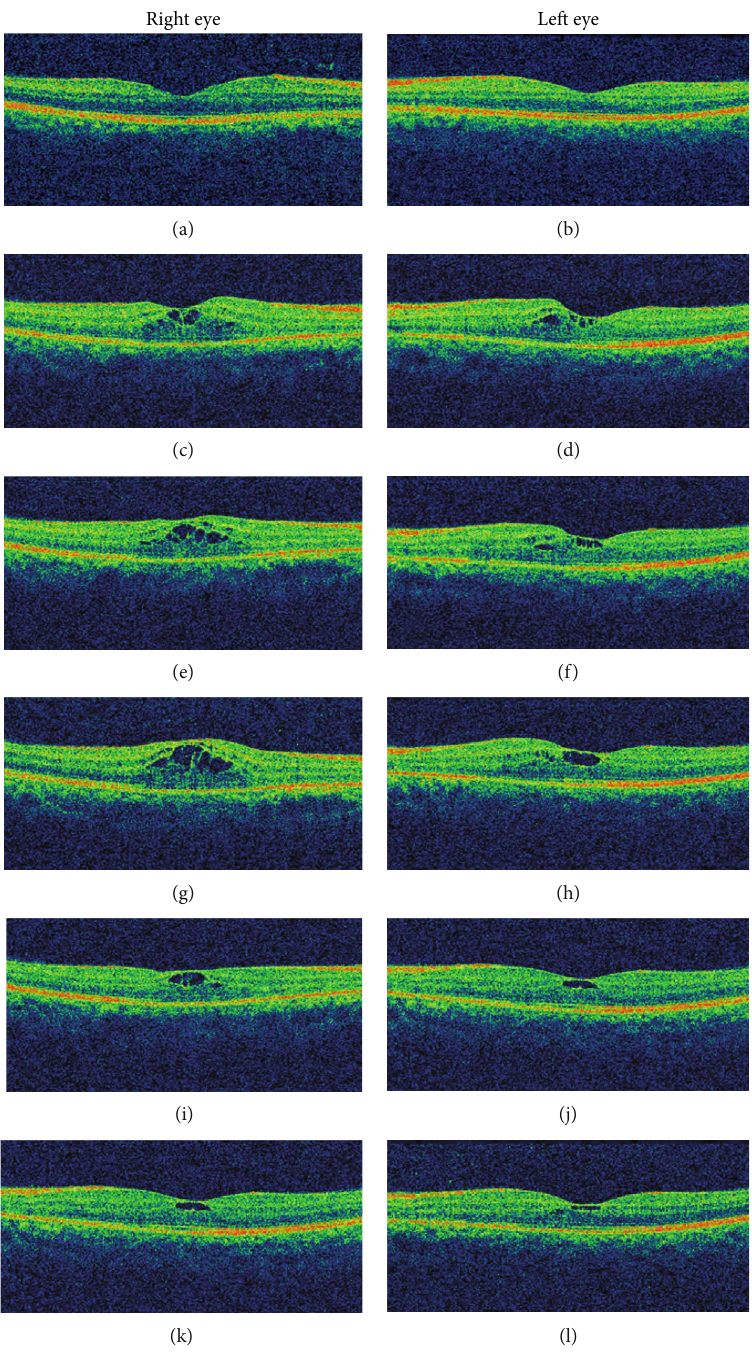
Figure 11: (a) – (l) Serial OCT scans showing the evolution of maculopathy obtained at the time of presentation to the last follow-up visit at the end of fi ve months postinjury. (a, b) OCT at presentation showing normal appearance. (c, d) OCT at three weeks of injury with development of intraretinal cystoid abnormalities. (e, f) Five weeks following injury showing increment in cystoid changes. (g, h) Interval increment in macular thickness as well as cystoid pockets more marked in the right at the end of two months. (i, j) Four months interval with decreased cystoid changes in both eyes. (k, l) OCT at the end of last follow-up visit at fi ve months showing resolution of cystoid spaces and restoration of fovea in the right; however, presence of foveal cyst in the left was